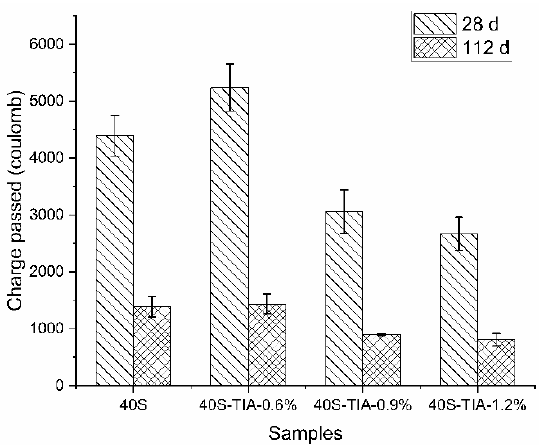
Figure 6. Charge passed through concrete with 0%, 0.6%, 0.9% and 1.2% NPI at 28 days and 112 days,